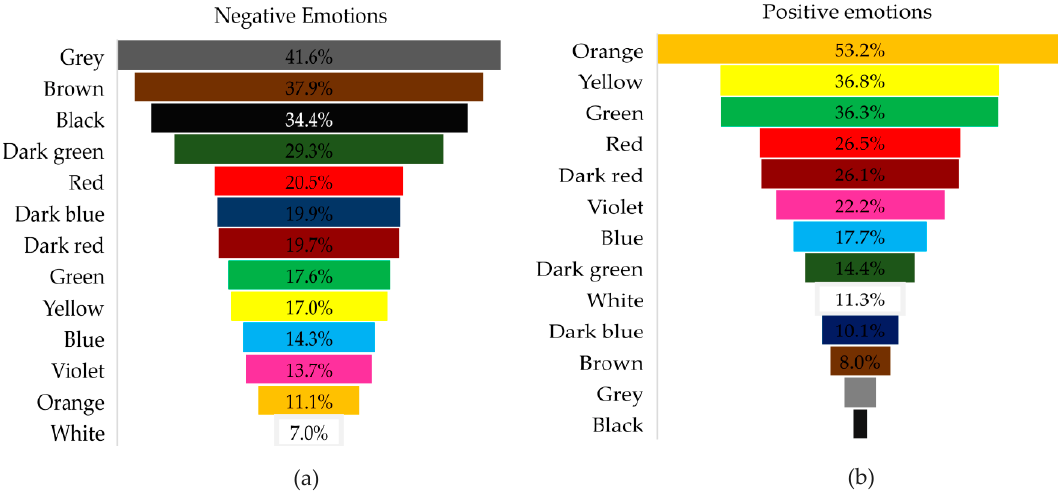
Figure 8. Percentage frequency of color choices to express the evoked emotion(s). ( a ) The color choices to express negative emotions. ( b ) The color choice to express positive emotions .